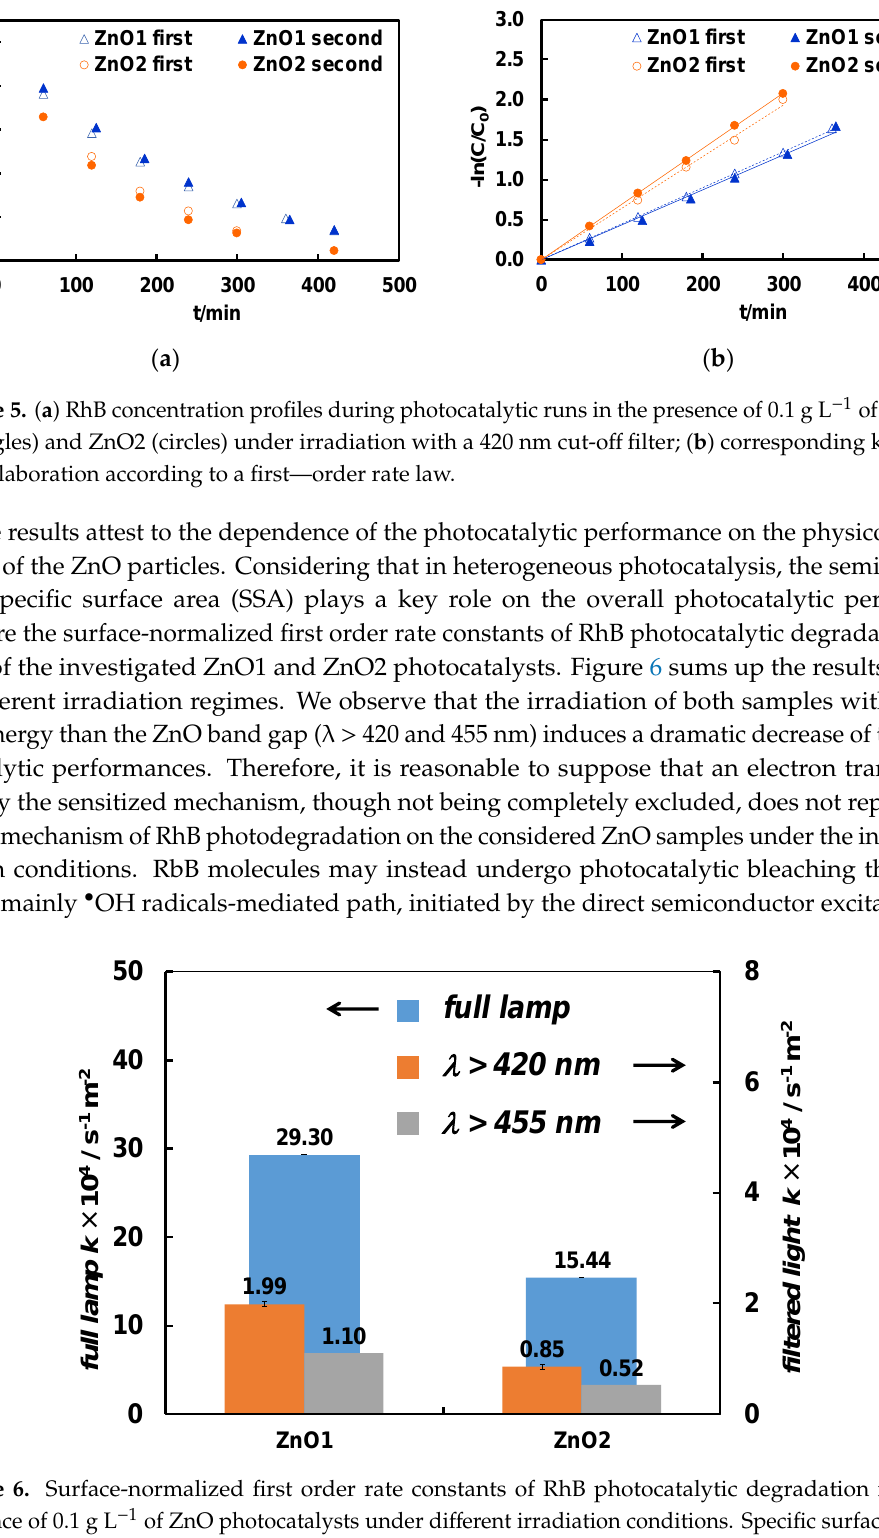
Figure 4. Time-gated spectra (delay after laser excitation = 0.5 μs; gate width = 10 μs) of the trap- assisted PL emission of sample ZW1 at different excitation energies between 335–413 nm (3.0–3.7 eV). 3.4. Photocatalytic Activity Study In order to investigate how the defective structure and the specific surface area of ZnO may affect the semiconductor tendency to oxidize organic molecules contained in the pigment binding medium under light irradiation, preliminary photocatalytic degradation tests are performed in the presence of zinc oxide analytical grade samples characterised by different PL properties, i.e., ZnO1 and ZnO2 materials. This choice is made in order to avoid the additional contribution of zinc carbonate hydroxide present in zinc white samples. Finally, the cationic dye Rhodamine B (RhB), showing an aromatic structure derived from anthracene with two amino and one benzoic acid-based substituents (see Scheme S1), is chosen as the model organic pollutant to be photodegraded. RhB, as most organic molecules, undergoes photodegradation through an oxidation path, initiated either by direct electron transfer to positive valence band holes (h +VB ), photogenerated upon the semiconductor bang gap excitation, or by the attack of hydroxyl radicals, formed upon h +VB - induced oxidation of water molecules or adsorbed –OH groups [33–36]. At the same time, these dye species are able to absorb a considerable portion of visible light under the adopted irradiation conditions. Therefore, a dye-sensitized photocatalytic reaction path might be at work, in parallel to that initiated by semiconductor band gap absorption. In fact, the electronically excited state of the dye, produced by visible light absorption, is able to transfer electrons into the conduction band (or electron acceptor states) of ZnO, thus producing a dye radical cation, which easily undergoes oxidation by further interaction with adsorbed O 2 molecules [36,37]. In this scenario, aiming at excluding the combined excitation of both the semiconductor and the organic substrate molecule, three types of time-dependent runs have been performed, respectively at full lamp irradiation and in the presence of 420 and 455 nm cut-off filters. In fact, when using lamp irradiation above 420 and 455 nm, ZnO is expected to be minimally or not photo-excited. Hence, in these two irradiation regimes, the resulting RhB degradation, if present, should be inferred to the direct excitation of the organic dye. RhB is stable in aqueous solution under the here adopted full